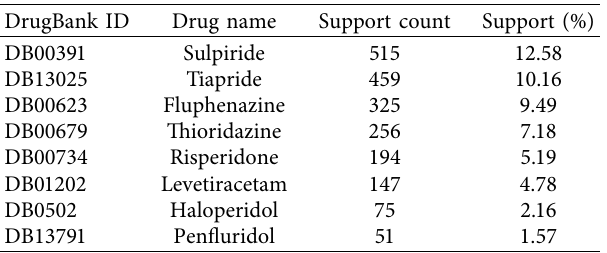
Figure 9: Network model of schizophrenia drugs. Table 3: Examples of some schizophrenia-related drugs and their support values.